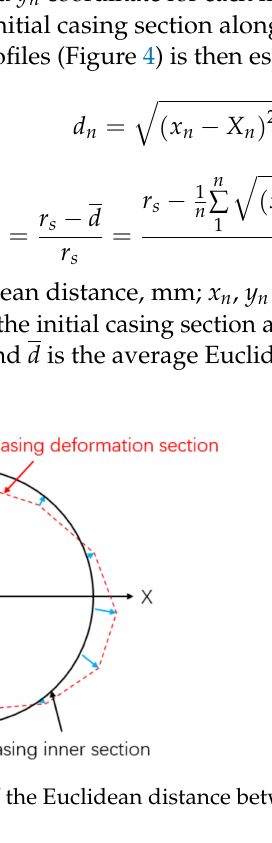
Figure 4. A schematic of the Euclidean distance between the initial casing section and the elliptical casing section.